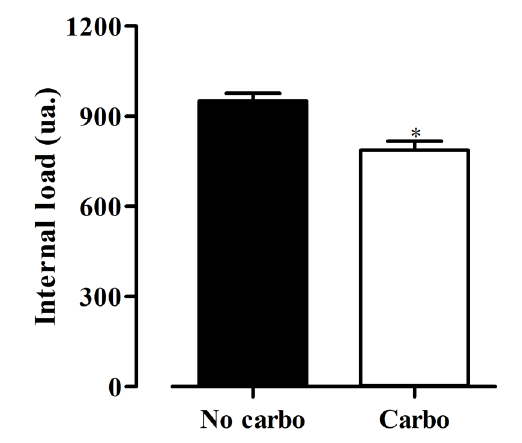
Figure 3. Values expressed in mean ± SD of internal load in arbitrary units evaluated 30 minutes after the end of the session after placebo or carbohydrate supplementation intake. au: Arbitrary units *significantly different from no carbo (p=